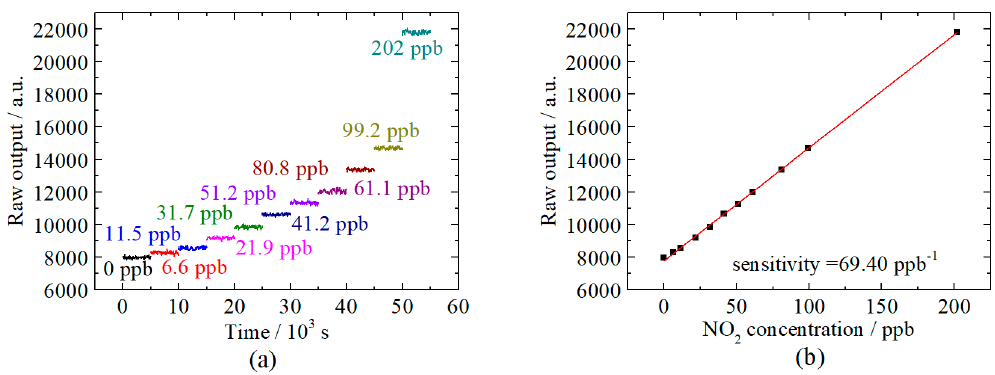
Figure 5. Calibration of the NO2 sensor. (a) The stable output of the sensor measuring the samples in a concentration range from 0 to 202 ppb. (b) The linear dependence of the output of the sensor upon the NO2 concentration.